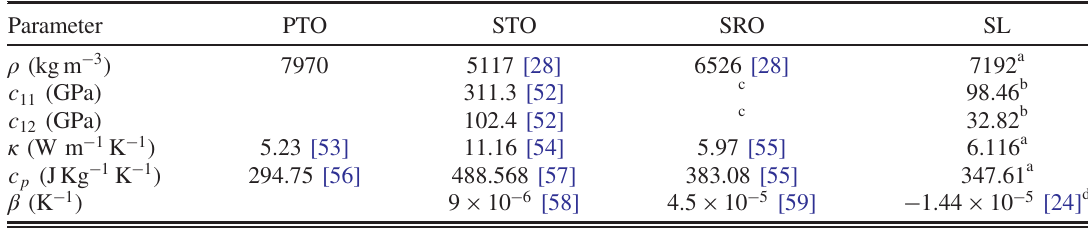
a Weighted average of values for PTO and STO. b Determined using the measured longitudinal sound velocity v ¼ 3700 m = s and Poisson ratio 0.25. c c The values of c 11 and 12 for SRO taken to be the same as STO, following the reported similarity of values of elastic parameters for SRO and STO [60]. d The value of β for the optical excitation experiment was calculated by subtracting the additional lattice contraction effect arising from the thermal expansion of the substrate.